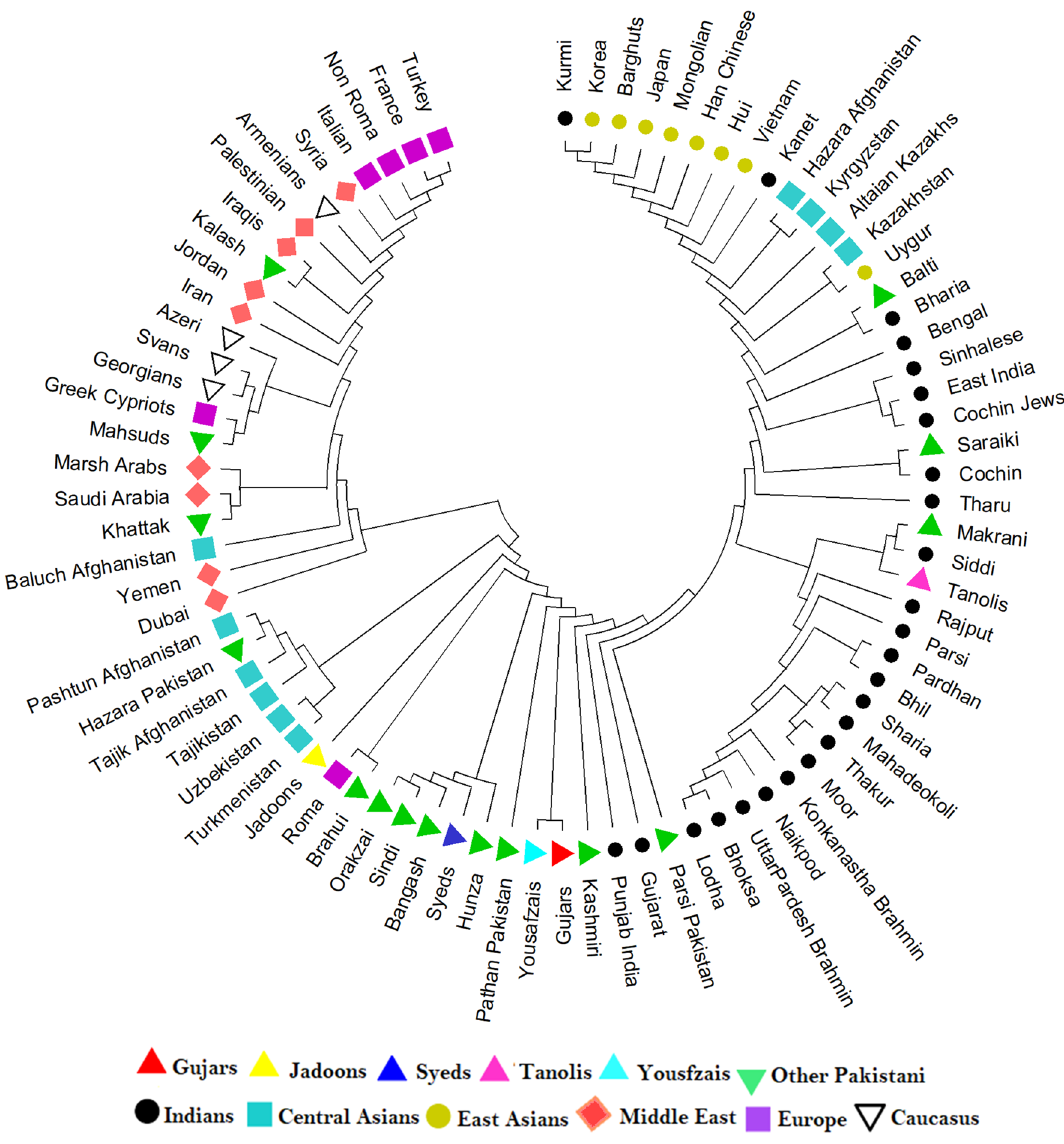
Figure 2. A Neighbor-Joining tree showing the genetic relationships between KPP ethnic groups and 77 world populations based on F ST estimates from mtDNA HVS1 sequence data (Table